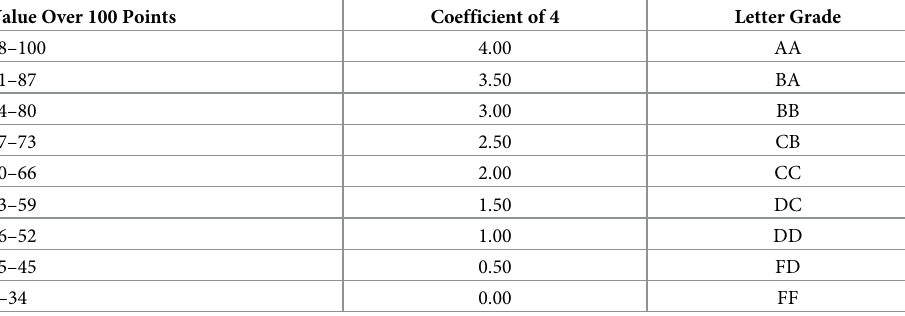
Table 1. Note categorization